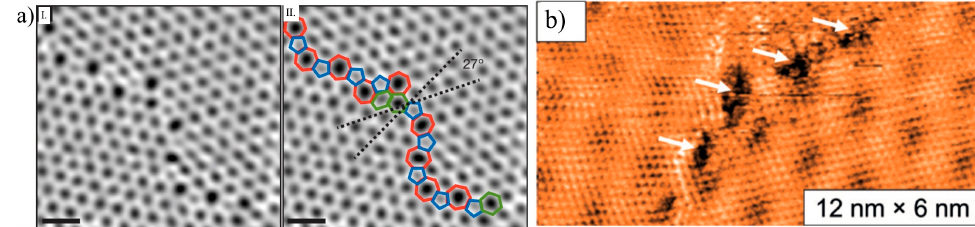
Figure 7. ( a ) Annular dark-field STEM image of graphene lattice: ( I ) grain boundary with defect sites, ( II ) outline of different types of defects such as pentagon ( blue ), distorted hexagon ( green ), heptagon ( red ). In addition, the two stitched grains are inclined at 27° relatively; ( b ) Scanning tunneling microscopy (STM) image of defect sites in the grain boundary. Reprinted with permission from ref. [118,119]. Copyright 2011, 2017 Springer Nature Limited, and John Wiley & Sons, Inc. respectively.